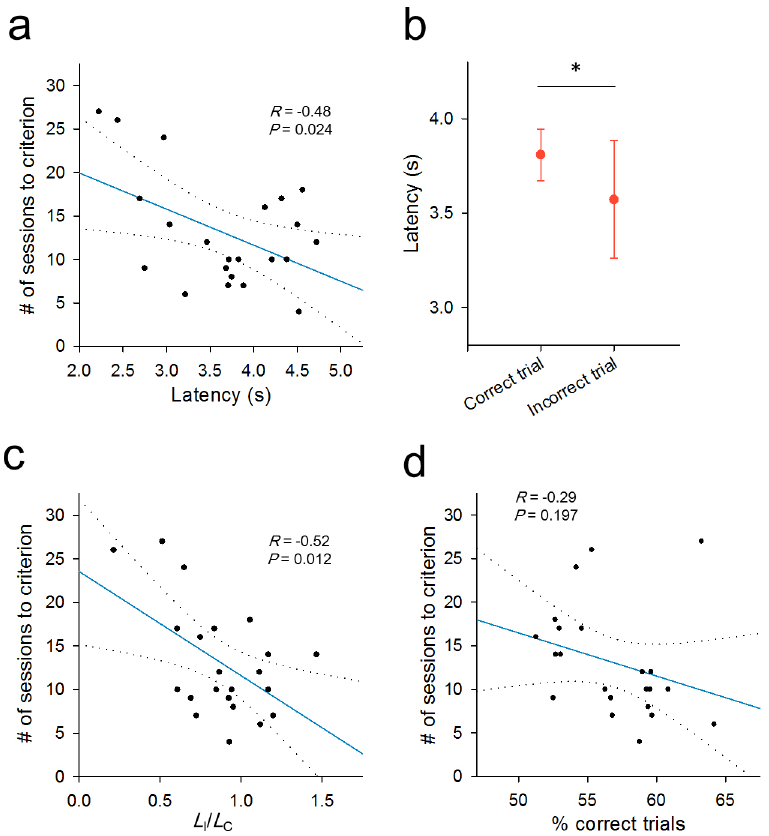
Fig 5. Relationship between nose-poke latencies in the during-learning period and task performance. (a) The number of sessions spent to reach the criterion is plotted against the latency to respond. Each dot indicates data from a single rat. The blue line is the best-fit line determined by the least-squares method, and its 95% confidence intervals are shown by two broken lines. As a whole, rats with shorter latencies reached the criterion more slowly ( P = 0.024, R = -0.48, Pearson’s correlation test, n = 22 rats). (b) The latencies of individual trials are separately plotted for correct trials ( L C ) and incorrect trials ( L I ). L I was significantly shorter than L C ( P = 0.016, bootstrap resampling test). Error bars represent SEMs for 22 rats. (c) Same as a, but against the latency ratio L I / L C . Rats with a smaller L I / L C ratio learned more slowly ( P = 0.012, R = -0.52). (d) Same as a, but against the mean correct-trial ratio from the beginning of the test phase to the first session that reached the criterion ( P = 0.197, R =